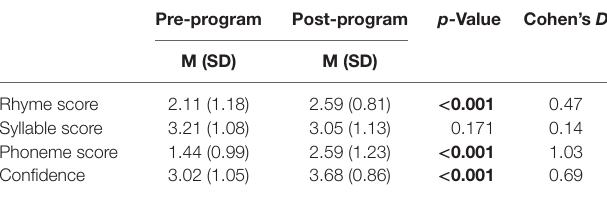
TaBle 2 | Phonological awareness and confidence scores at pre- and post- program assessments.